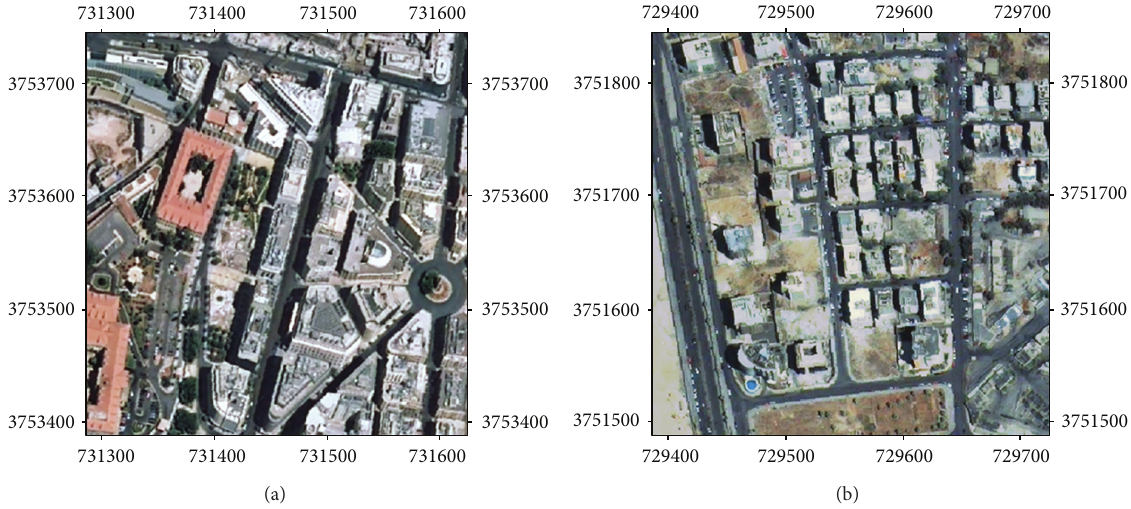
Figure 2: QuickBird-enhanced original images: (a) first experiment, (b) second